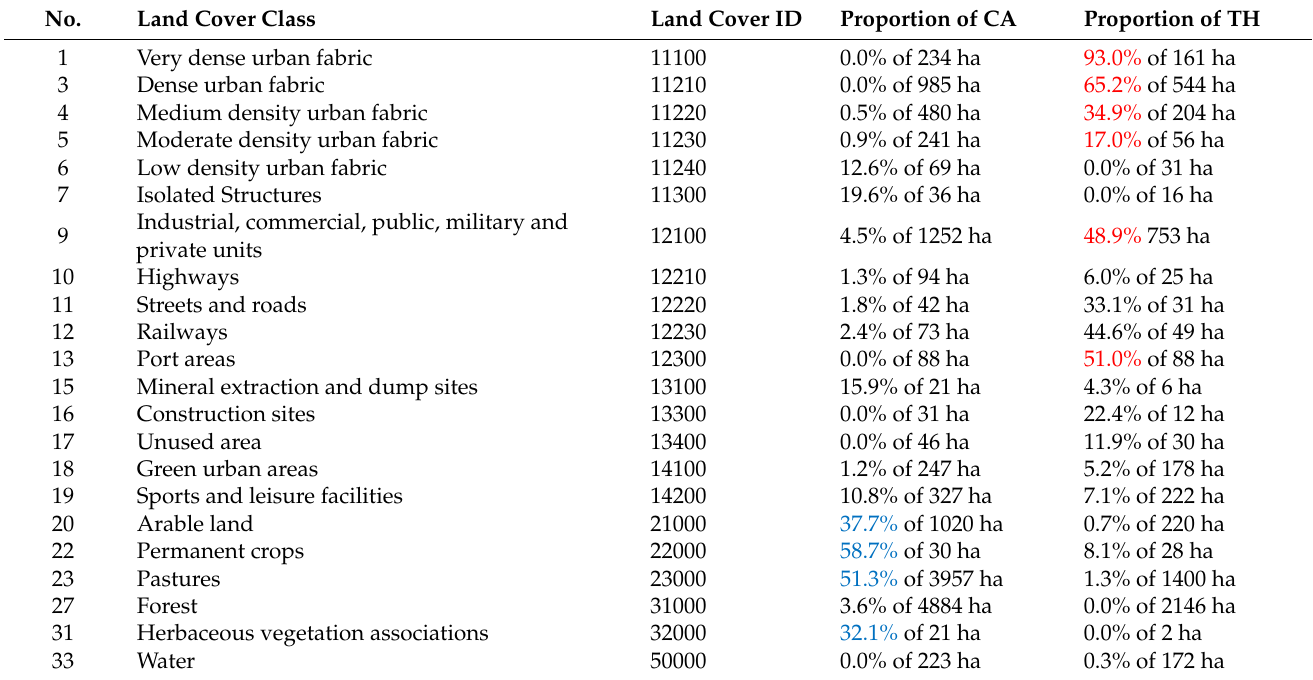
Table 1. Copernicus Urban Atlas 2012 [41] land cover classes in the model area and their fractions identified as cold air formation areas (CA) and thermal hot spots (TH). Additionally shown is the area the land cover class covers in the 12 km × 12 km domain (CA) and inside the city border of Aschaffenburg (TH). Highlighted in red (land cover THs) and blue (land cover CAs) are the land cover classes used in Figure